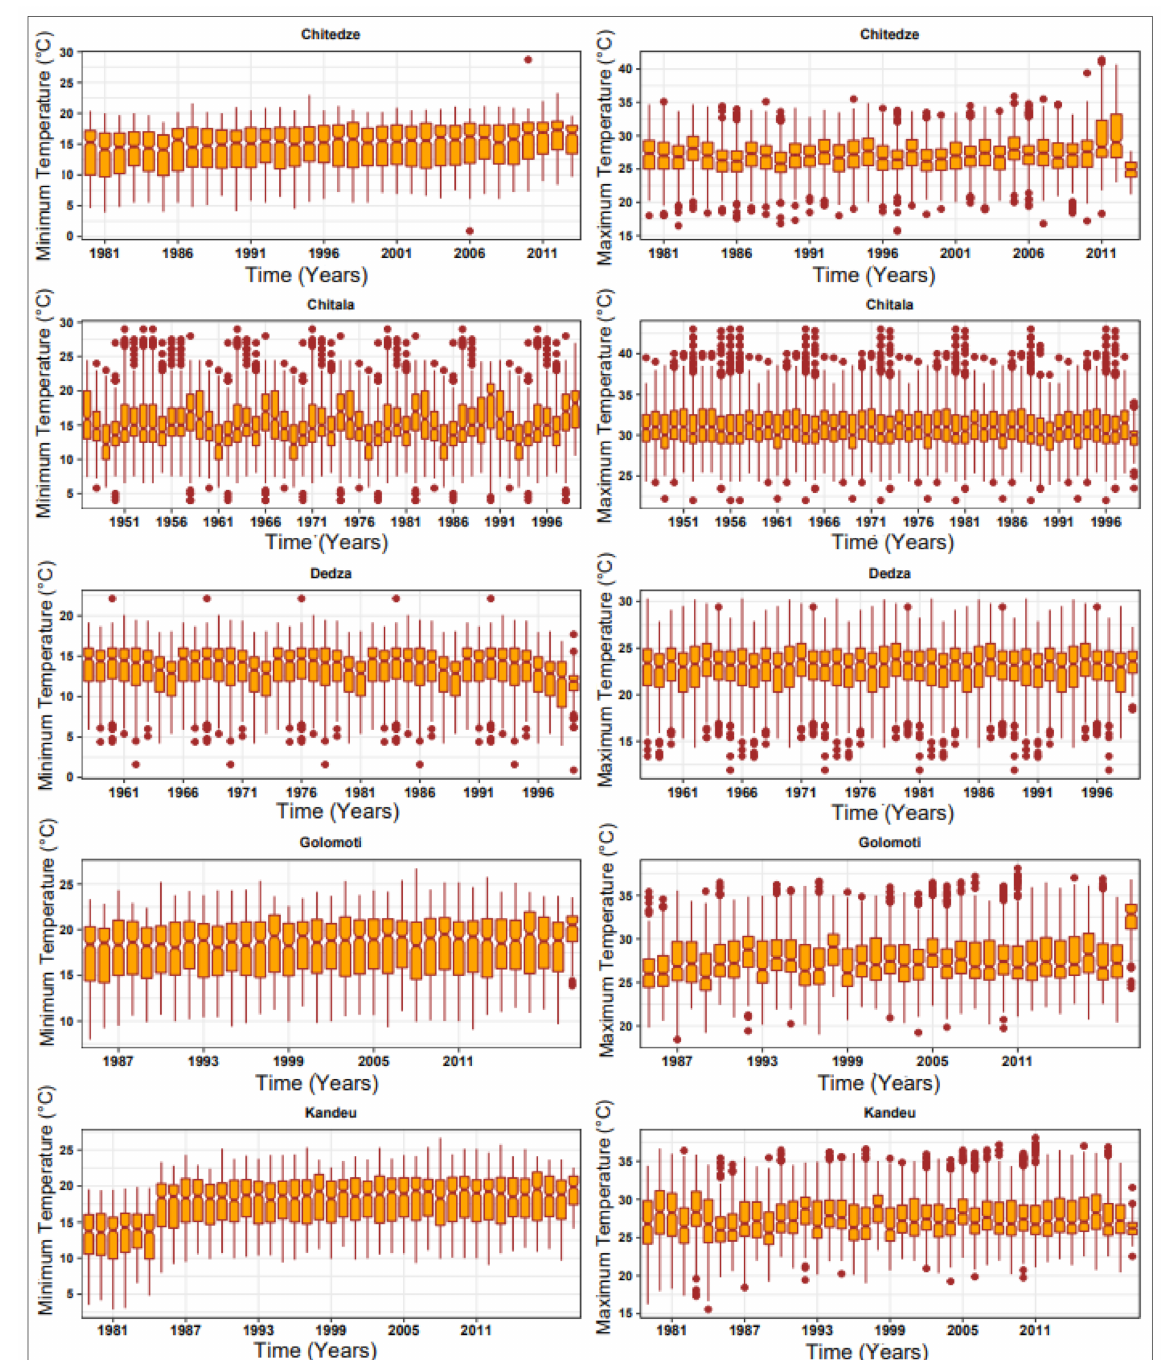
Figure 2. Minimum and maximum temperature trends at five locations in Malawi over varying periods between 1947 and